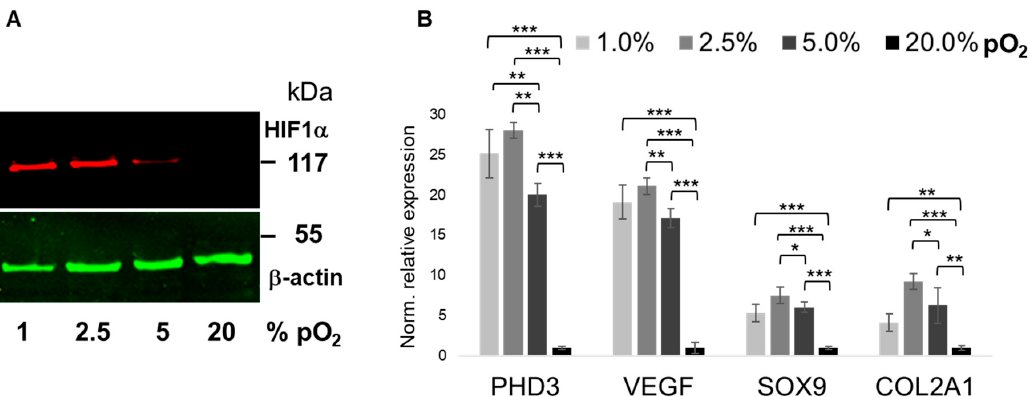
Figure 1. Validation of hypoxic conditions and its effect on marker gene expression. Figure shows representative HIF-1 α protein expression next to that of β -actin as loading control ( A ). Relative mRNA expression of hypoxia- and chondrocyte-specific markers ( B ). As expression of all four markers was significantly suppressed under “hypoxic” conditions ( ≤ 5% pO 2 ), as compared to “normoxic” conditions (i.e., 21% pO 2 ), we confirmed robust oxygenation levels within the micro-bioreactor. Screening of marker gene expression after 48 h further revealed significant differences in mRNA levels between 1% and 5% of oxygenation and also between 2.5% and 5% pO 2 . Oxygenation levels are shown as grey scales of increasing intensities from 1% to 21%, respectively. Molecular weight (kDa) is indicated; Western blots ( n = 3), RT-qPCR ( n = 6); * p < 0.05, ** p < 0.01, *** p < 0.001.